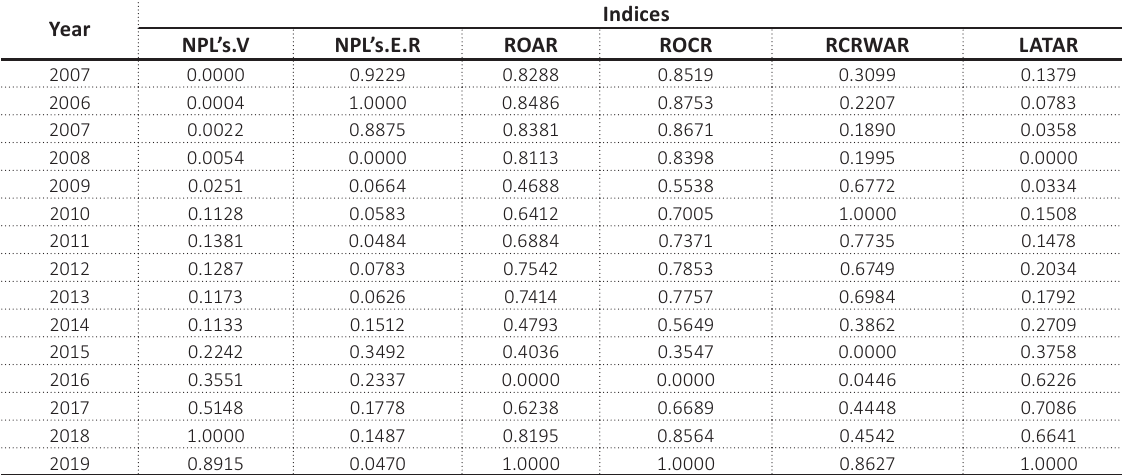
Table 3. Normalized output data for structural equation